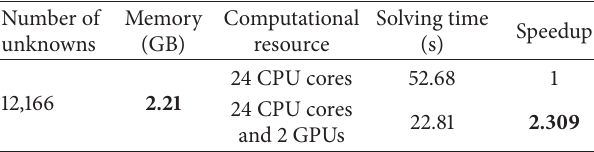
Table 1: Computational parameters for the array. Number of